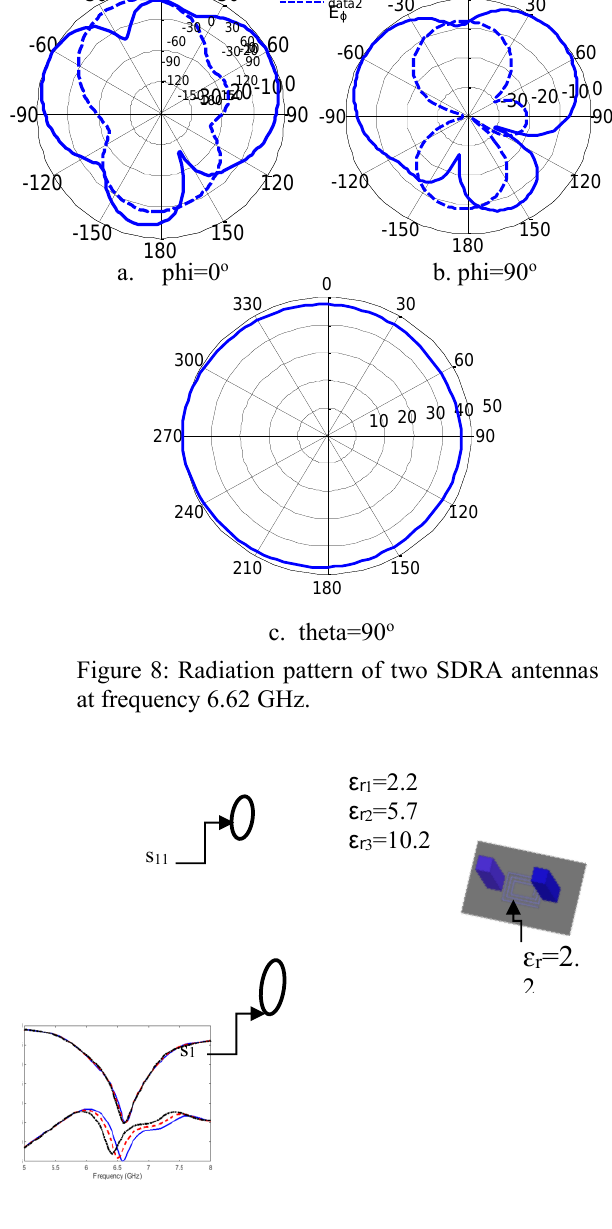
Figure 9: S-parameter simulation result of SDRA antenna array with DGS filling with dielectric- resonator material.